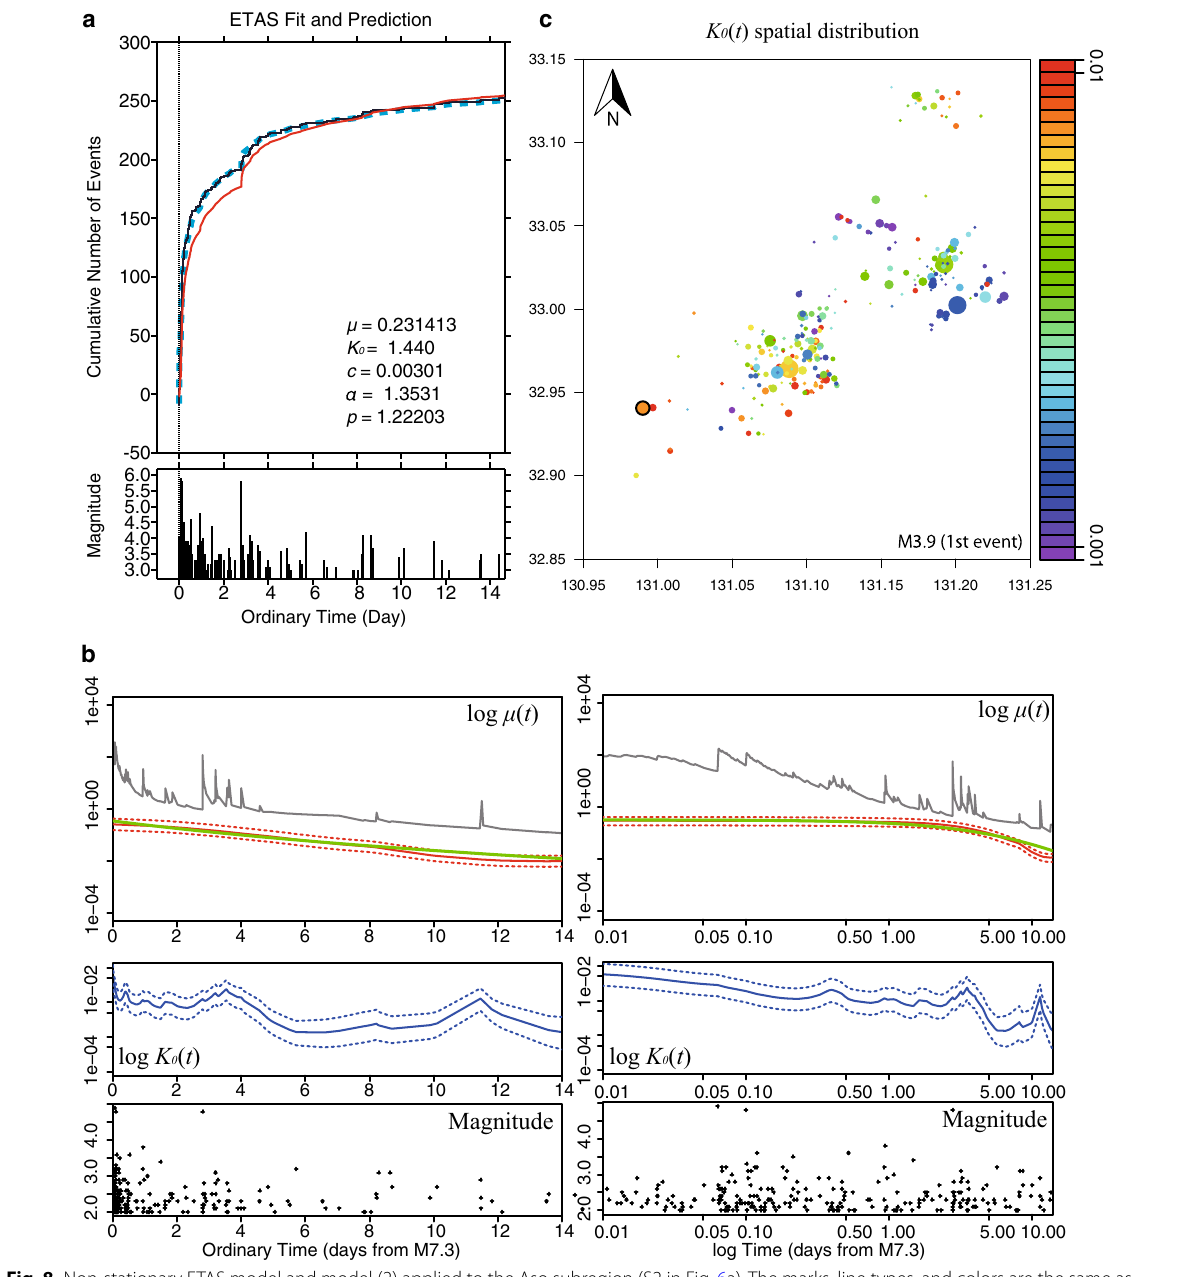
Fig. 8 Non-stationary ETAS model and model (2) applied to the Aso subregion (S2 in Fig. 6a). The marks, line types, and colors are the same as indicated in Fig. 7, except that the thick green curve represents the triggering effect of the M7.3 mainshock indicated by the third term in model